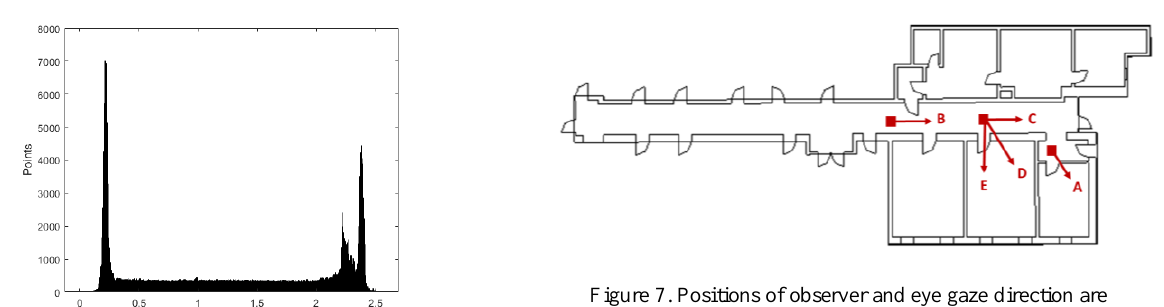
Figure 7. Positions of observer and eye gaze direction are represented in red in the building floor plane.